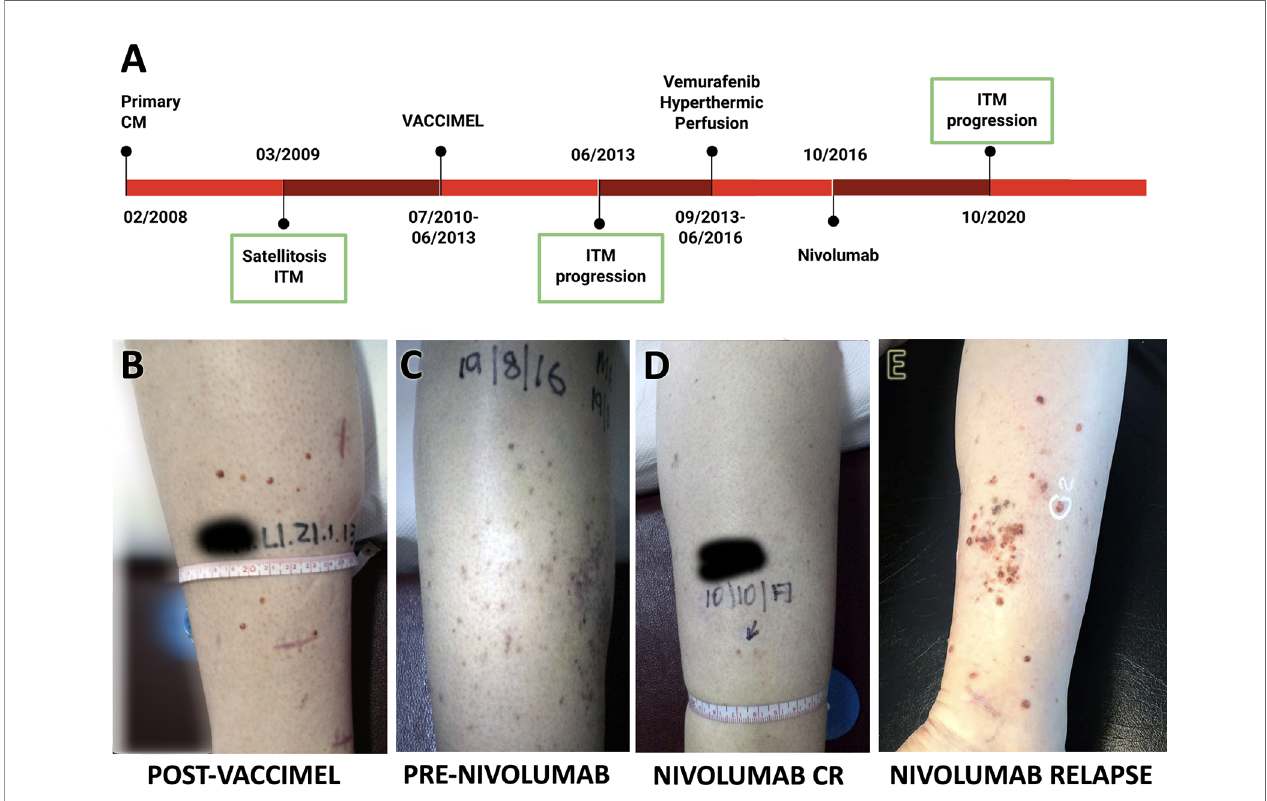
FIGURE 2 | Patient #5 case report. (A) Time course of the disease and treatments received. ITM biopsies analyzed are indicated with a green box. (B – E) Pictures of ITM on patient ’ s right leg: (B) relapse after ending vaccination protocol; (C) progression before nivolumab; (D) response after nivolumab 240 mg every 14 days for 1 year; (E) relapse after 4 years nivolumab, showing multiple red amelanotic 1- to 3-mm-wide